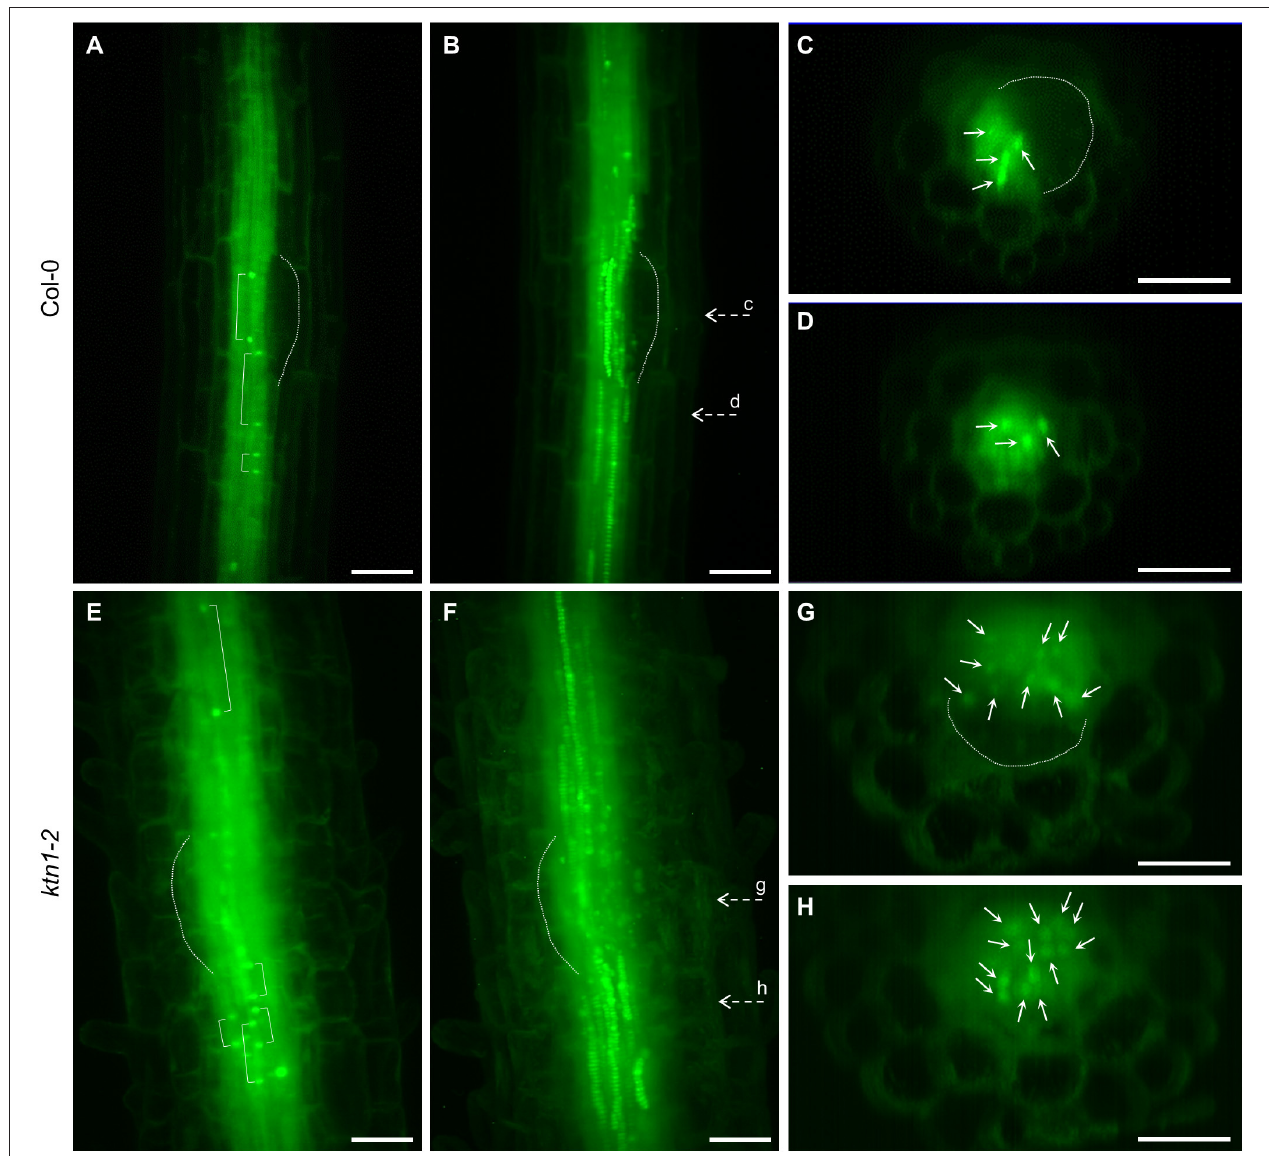
FIGURE 8 | Longitudinal cell divisions in the central cylinder at the region of first lateral root primordium formation in Col-0 and ktn1-2 mutant plants stably expressing a GFP-TUA6 microtubule marker. (A–H) Longitudinal cell divisions in Col-0 (A–D) , and ktn1-2 mutant plants (E–H) in the median section (A,E) , maximum intensity projection (B,F) , and orthogonal projections (C,D,G,H) corresponding to dashed arrows marked with small letters (c, d, g h) in (B,F) . Brackets show positions of the margins of late phragmoplasts (A,E) . Primordia are outlined by dashed line (A–C,E–G) . Bars: (A–H) 50 µ